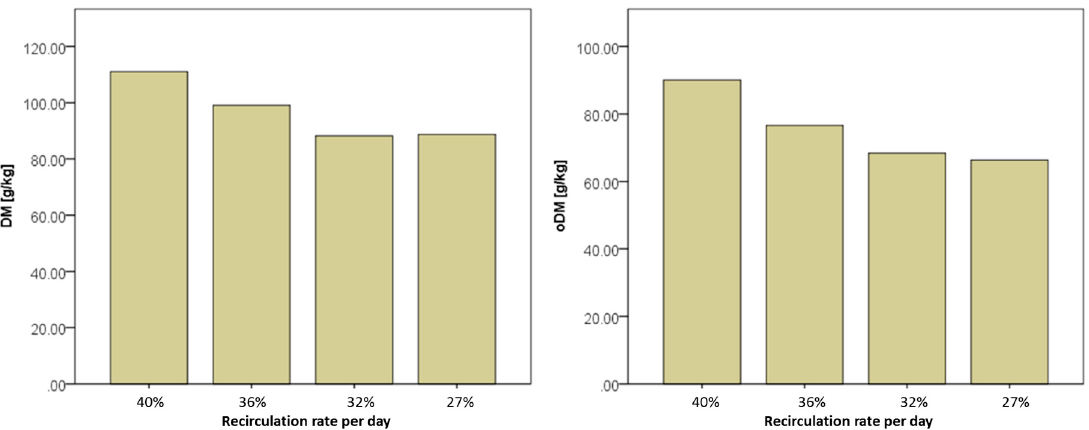
Figure 6. Dry matter (DM) and organic dry matter (oDM) contents in the biogas substrate as a function of recirculation rate.